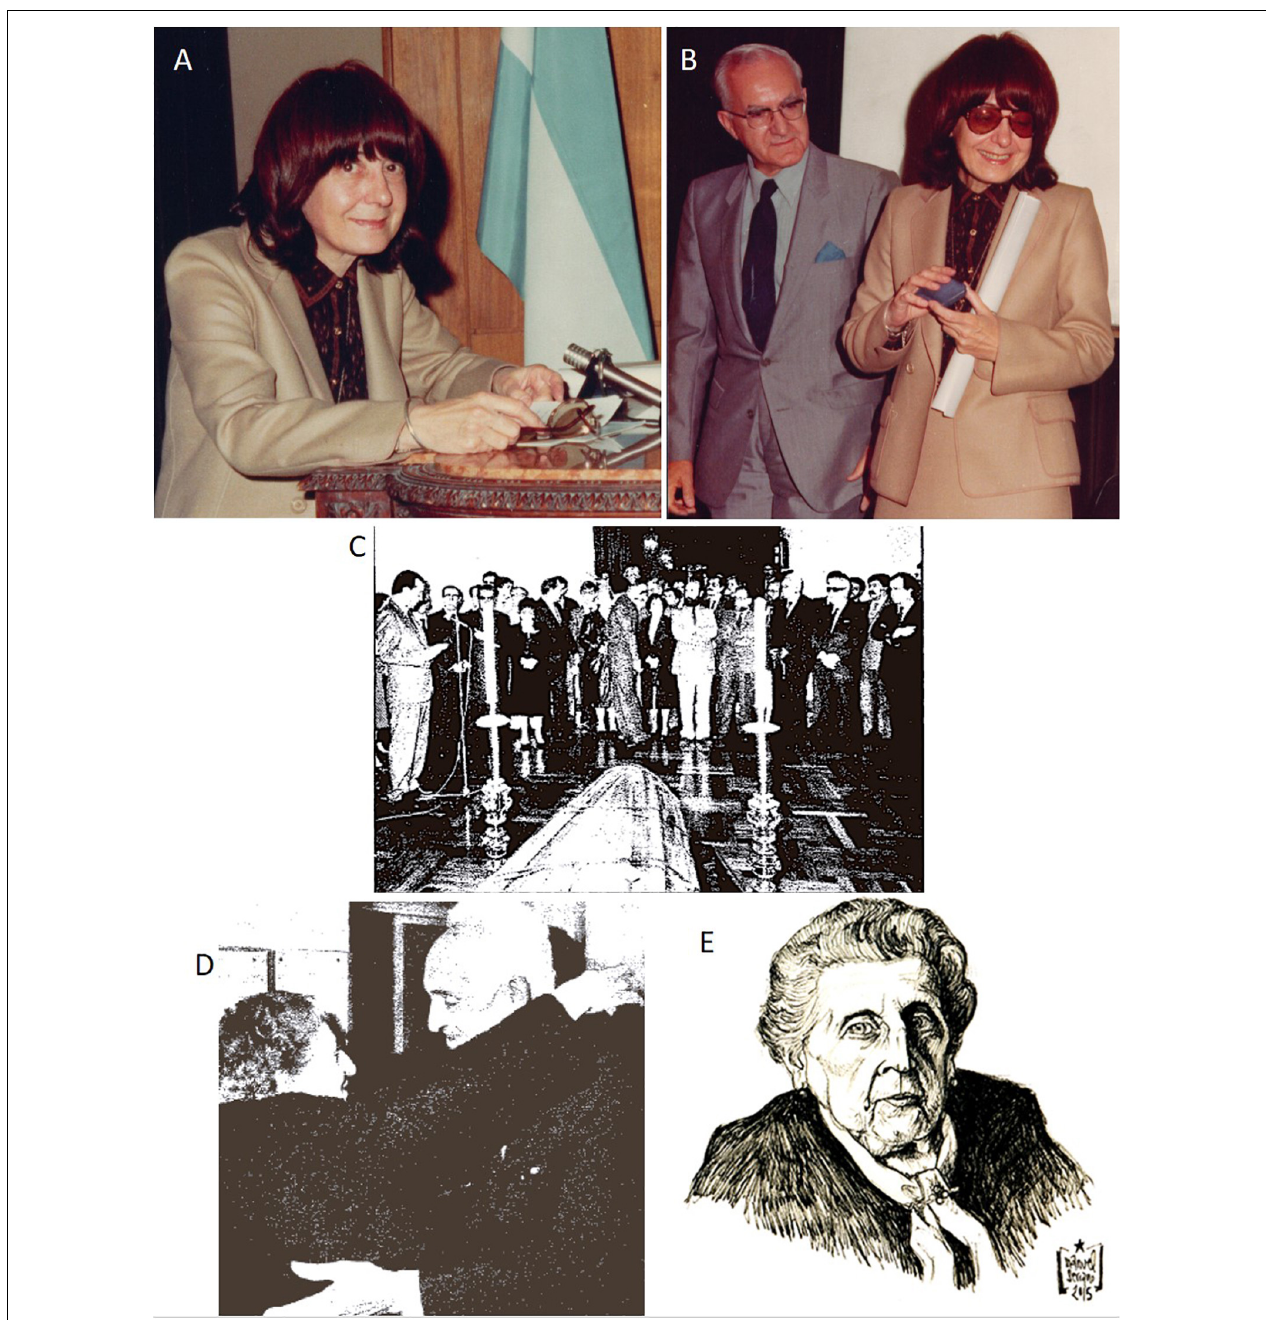
FIGURE 6 | The women disciples of Río-Hortega after the death of Don Pío (II). (A,B) Prof. Amanda Pellegrino de Iraldi substitutes Prof. Eduardo De Robertis (with her in B ) as Director of the Instituto de Biología Celular of the Universidad de Buenos Aires. (C) Reception of the mortal remains of Pío del Río-Hortega at Valladolid city town-hall (1986). Source: Archives at the newspaper ABC , issue published on October 14, 1986. (D) Asunción Amo del Río (on the left) embraces her old friend Prof. Severo Ochoa (Nobel laureate 1959) during the reception of the mortal remains of Pío del Río-Hortega in Valladolid (1986). Source: Archives at the newspaper ABC , issue published on October 14, 1986. (E) Portrait of Asunción Amo del Río in her last days in Manzanares (Ciudad Real) in